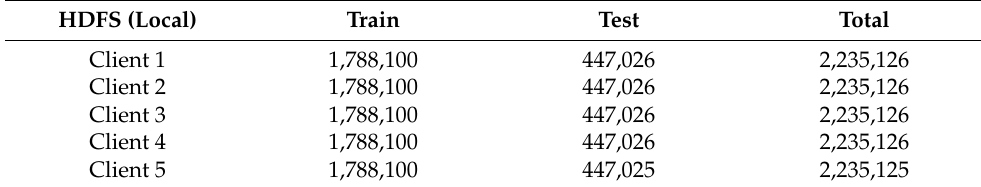
Table 4. HDFS datasets for each local server learning.